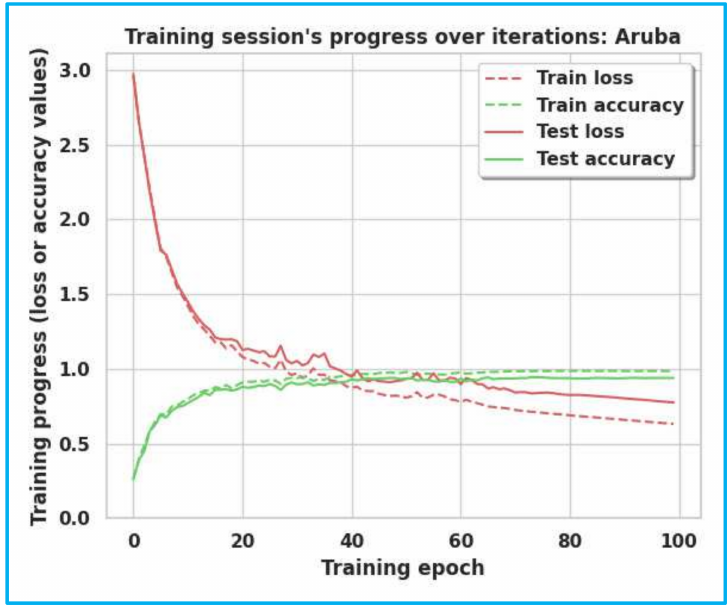
Figure 7. Training/Test Accuracy/Loss for Aruba.